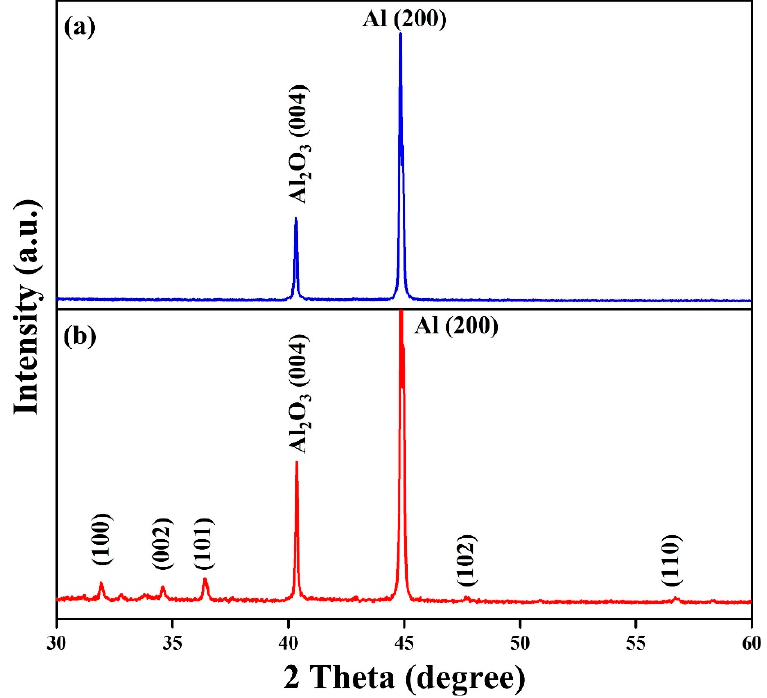
Figure 5. XRD diffraction pattern of ( a ) Al foil and ( b ) ZnO nanowalls (50 mM). Figure 6a displays the FETEM image of ZnO nanowalls grown at the concentrations of ZnO precursors of 50 mM. The ZnO nanowall is composed of many small grains. The SAED pattern (Figure 6b) indicates that the ZnO nanowall is polycrystalline and